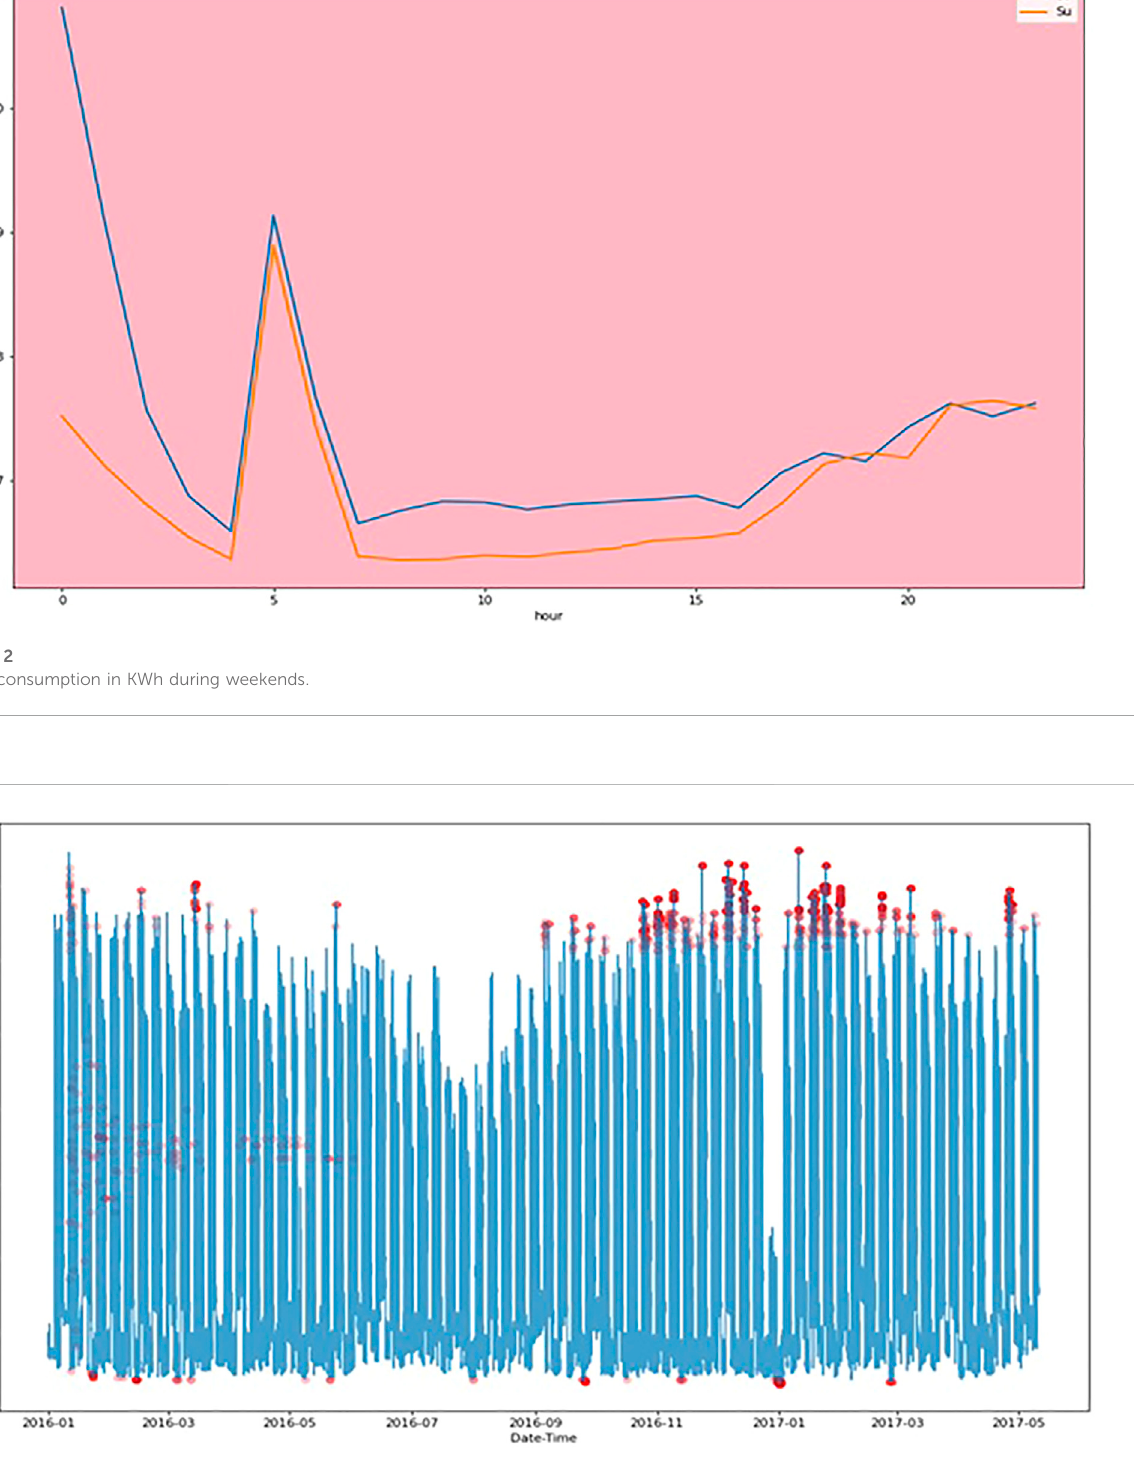
FIGURE 3 Detected